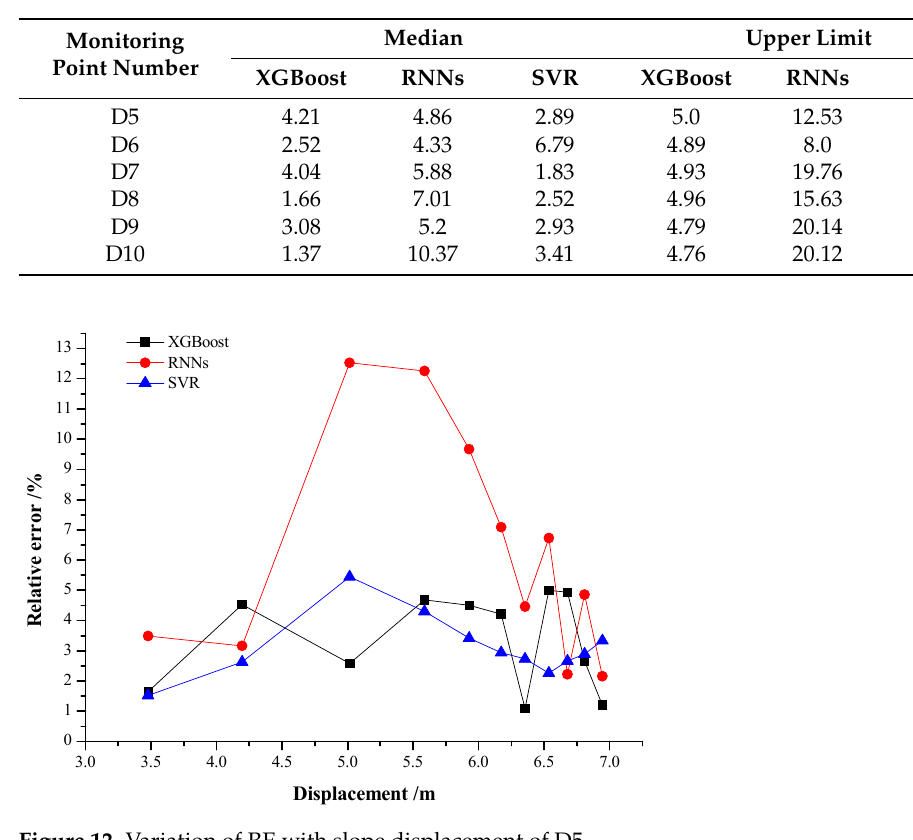
Table 1. Median of relative error and upper limit (%).